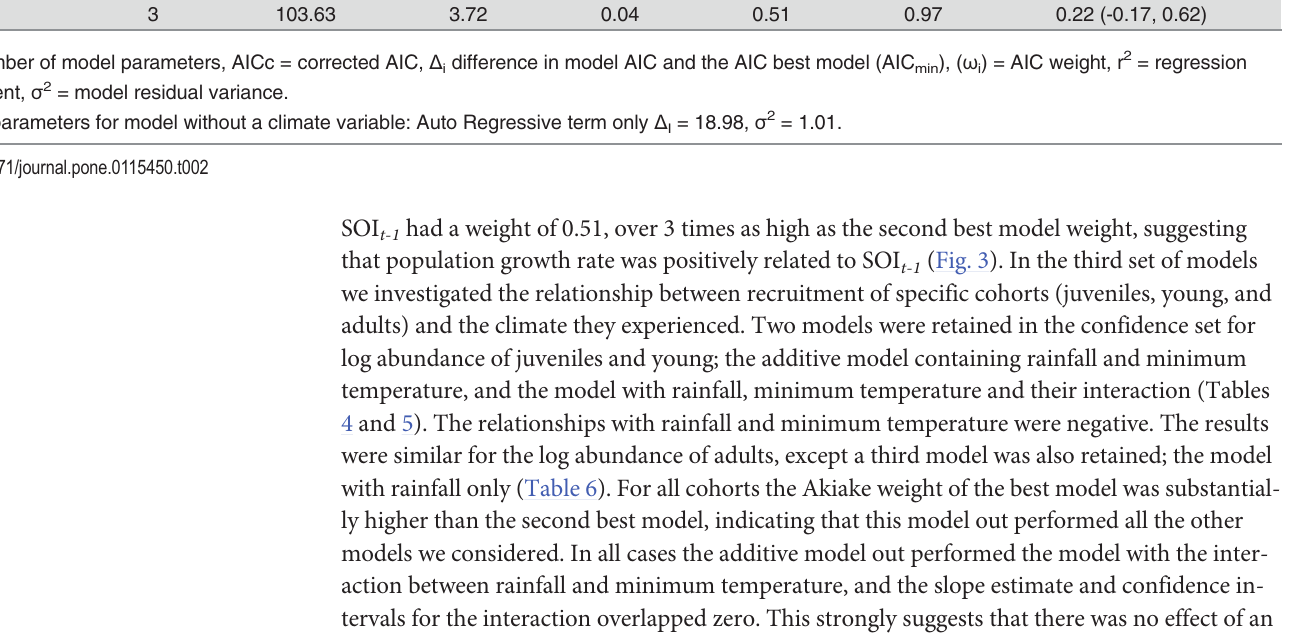
i difference in model AIC and the AIC best model (AIC min ), (